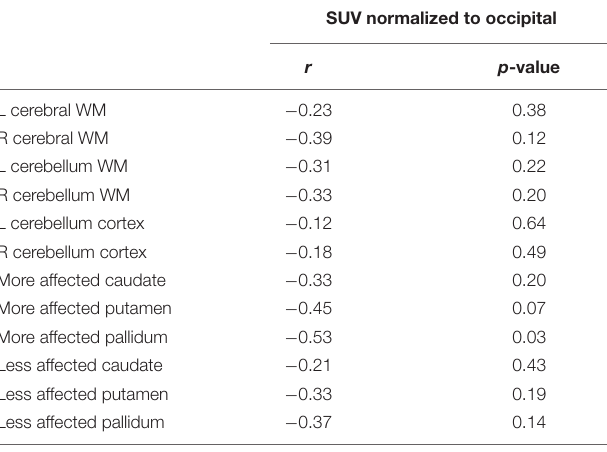
TABLE 4 | Correlation between striatal PE2I SUV and MoCA scores.